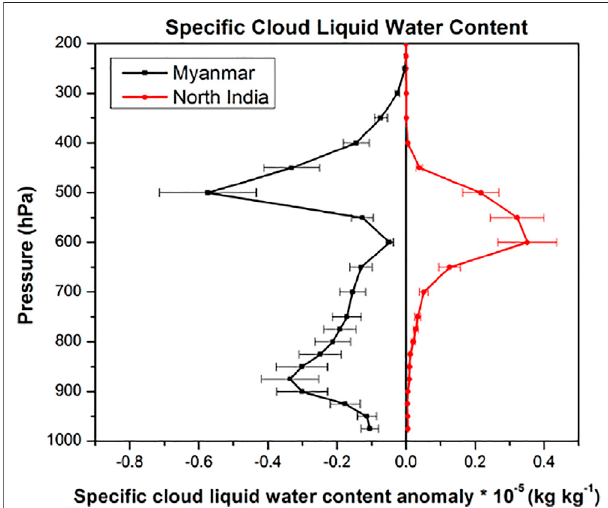
FIGURE 4 | Anomalous speci fi c cloud liquid water content for the two regions Myanmar (12 – 25 o N and 92 – 100 o E) and North India (22 – 30 o N and 74 – 81 o E) from the ERA data for the period of April-May. Horizontal lines in the fi gure indicate standard deviation.